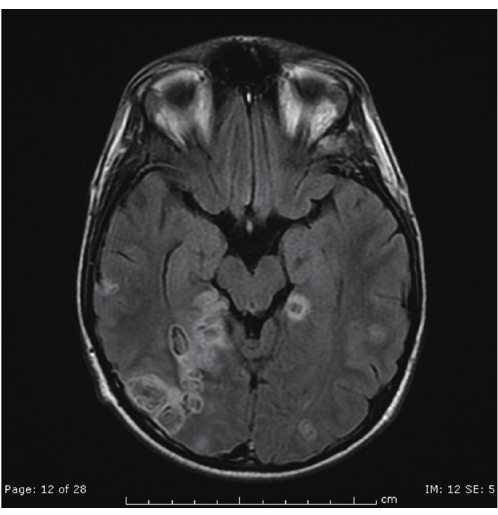
Figure 1: Multiple ring-enhancing and punctate areas of abnormal enhancement in the cerebral hemispheres bilaterally with some lesions demonstrating restricted di ff usion.